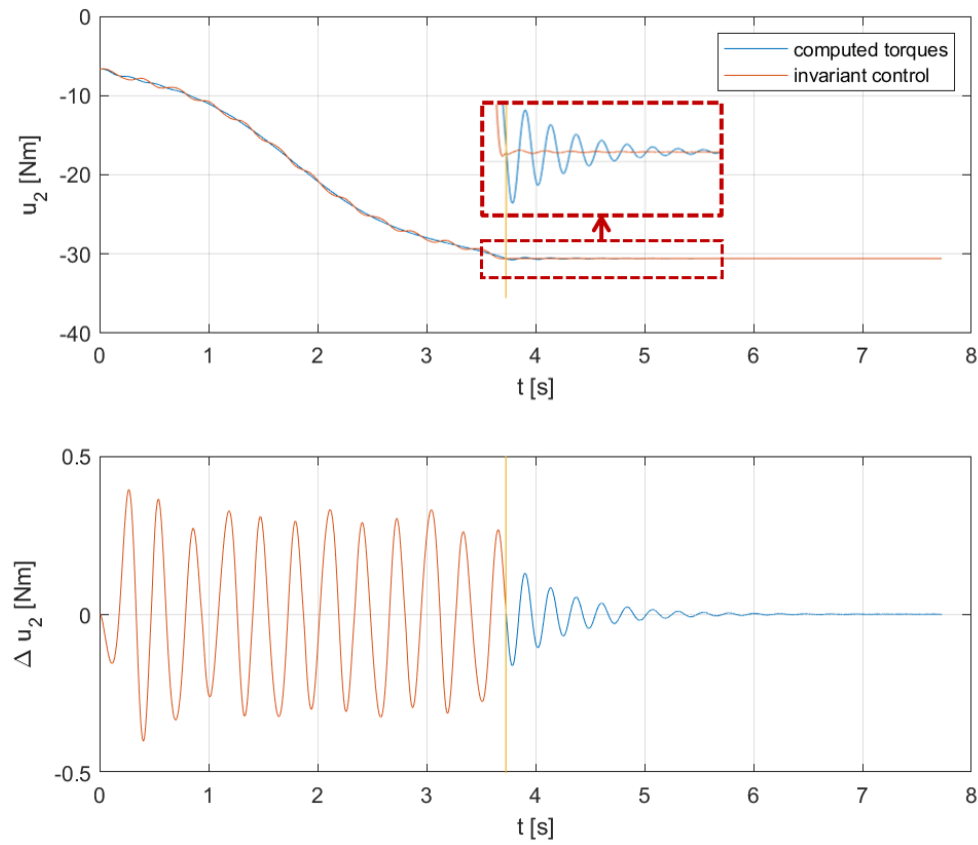
Figure 7. System input torque u 2 behaviour for two types of control—computed torques and invariant control and their